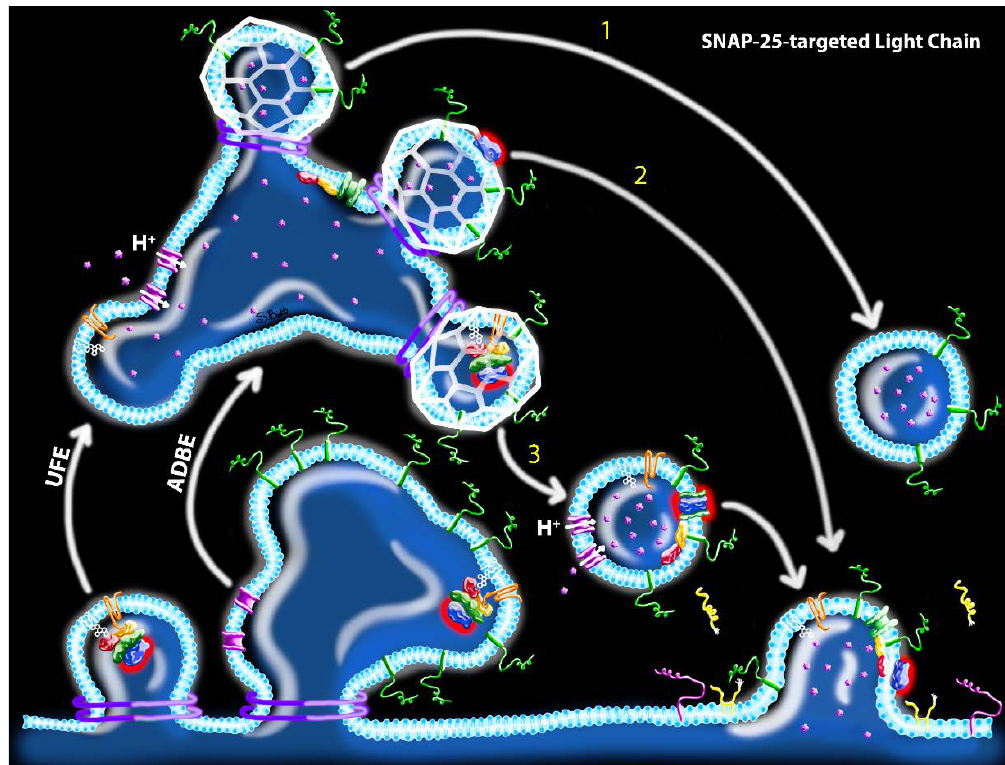
Figure 6. Hypothesized mechanisms of toxin uptake and potential proteolytic sites of action of SNAP-25-targeted LCs following UFE or ABDE. After fission from the presynaptic membrane, ABDE produces a bulk endosome, whereas UFE produces an endosome vesicle that subsequently fuses with a bulk endosome. vATPase proton pumps are activated during the bulk endosome stage, leading to slow acidification of bulk endosomes. Nascent SVs are produced from bulk endosomes via clathrin-coated (white) biogenesis with three potential outcomes: (1) sLC (blue with red halo) translocation occurs in bulk endosome, producing SVs that do not carry sLC; (2) Similar to step 1, except a translocated sLC is captured on the new SV; and (3) Acidification of the bulk endosome is not sufficient to drive translocation and intact holotoxin is captured within the SV during biogenesis. sLC translocation occurs after clathrin uncaging, producing SVs with active sLC. All scenarios produce fusion-competent SVs; however, in scenarios 2 and 3, sLC is deposited on the presynaptic membrane, where it subsequently cleaves SNAP-25 (yellow) in the vicinity of release sites. Structures correspond to the key in Figure 2.